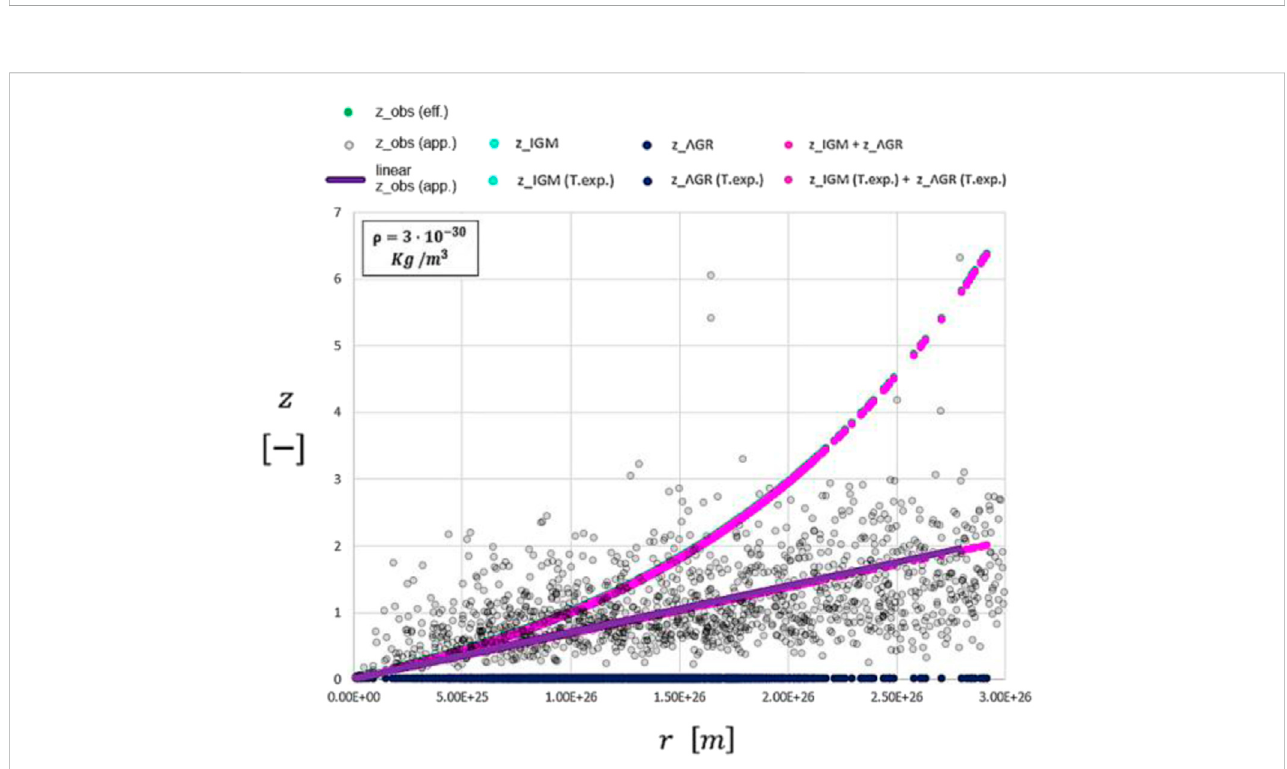
FIGURE 14 Plot of Figure 13 with a smaller matter density of the